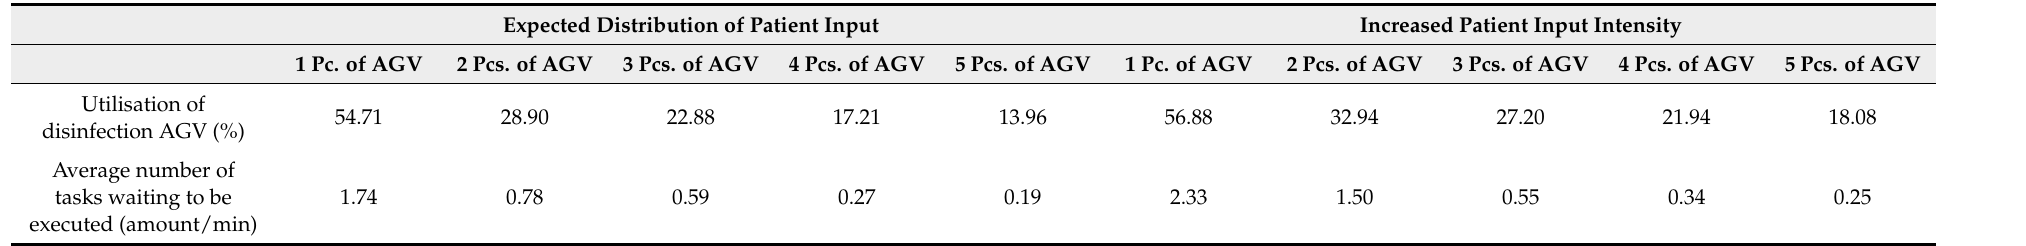
Table 2. Results of realised simulation experiments for disinfection with patients at locations.